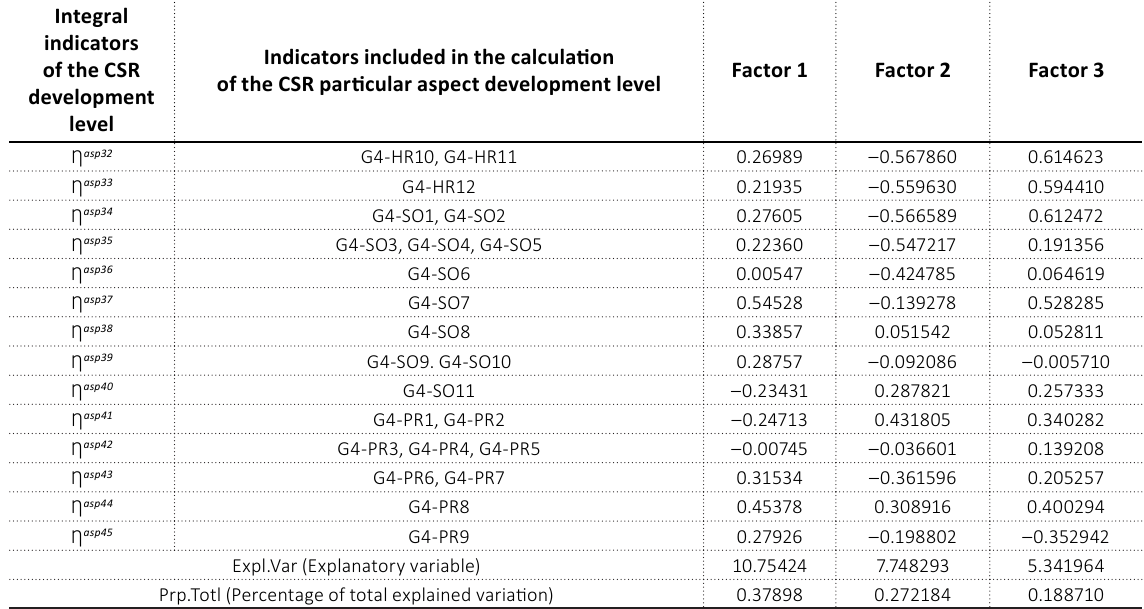
Table A1 (cont.). The results of the multivariate analysis on corporate social responsibility development